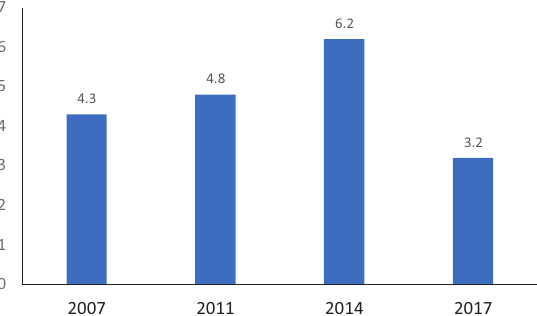
Figure 1. Weighted prevalence (percent) of the accidental fall by year